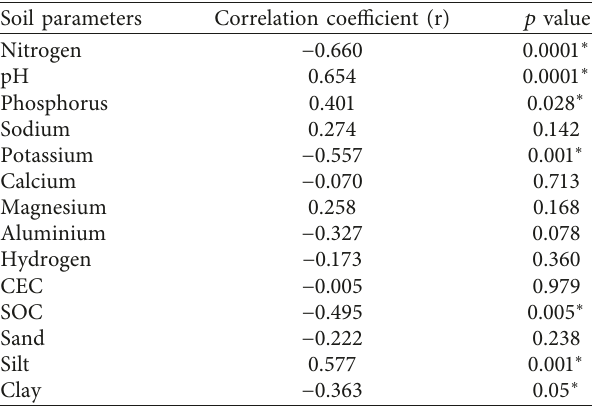
Table 5: Correlation between aboveground biomass and soil